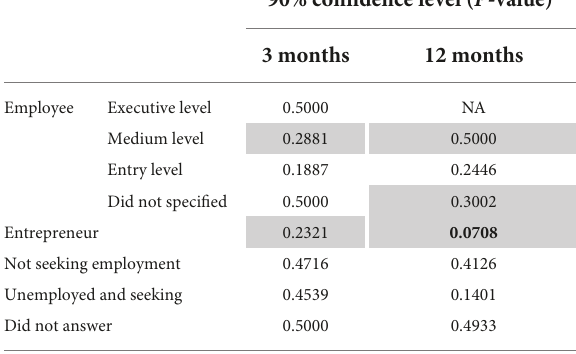
TABLE 2 Two-proportion Z -test between gender by evaluation period and work status a . Two-proportion Z -test with 90% confidence level ( P